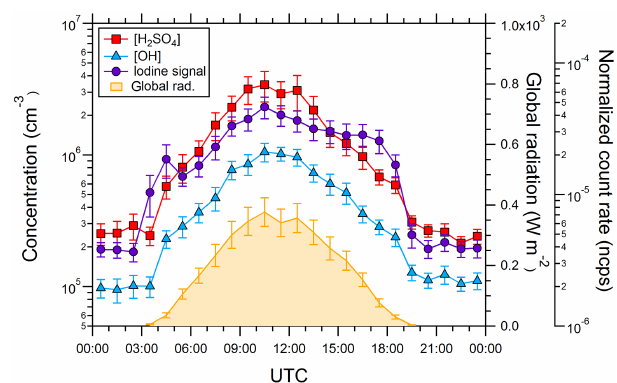
Figure 3. Diurnal averages for the sulfuric acid ([H 2 SO 4 ]) and the calculated hydroxyl radical ([OH]) concentrations (axis on the left). The iodine signal is not converted into a concentration; instead, the normalized count rates per second (ncps) are shown (axis on the right). A value of 5 × 10 − 5 ncps for iodine would correspond to a concentration of 3 × 10 5 moleculescm − 3 when applying the same conversion factor for iodic acid as for sulfuric acid. The global ra- diation indicates that all signals are related to photochemistry. Error bars indicate 1 standard deviation for the 30min averaged